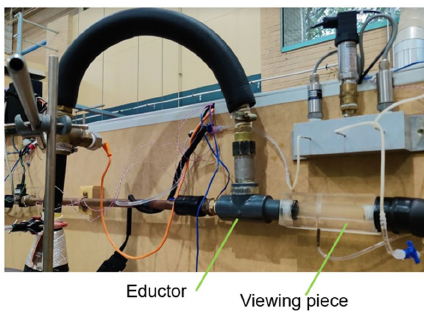
Figure 10. Visual inspection of bubbles.